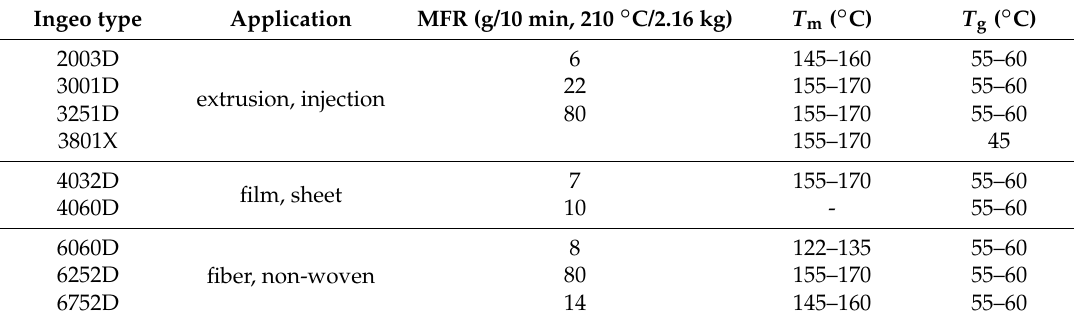
Table 4. Properties of commercial-grade Ingeo PLA [9].